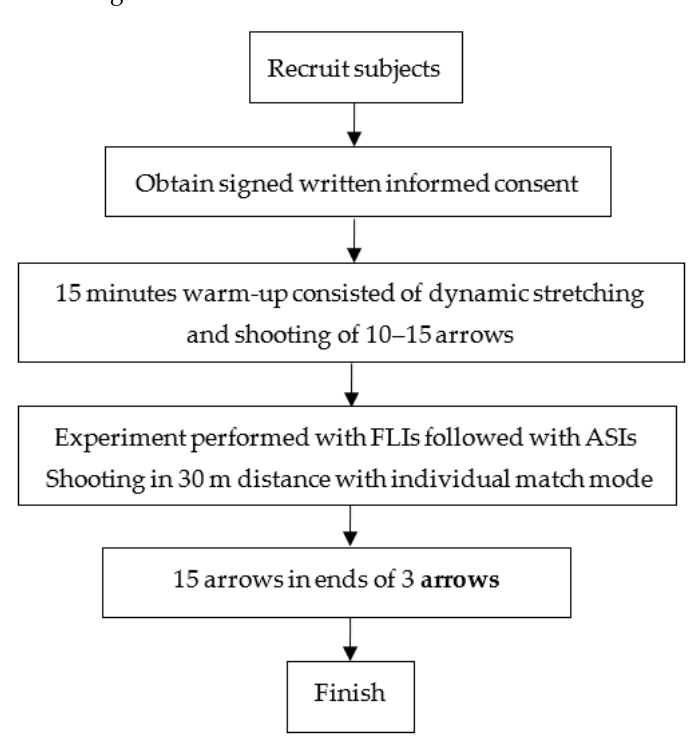
Figure 1. A schematic representation of the testing protocol.